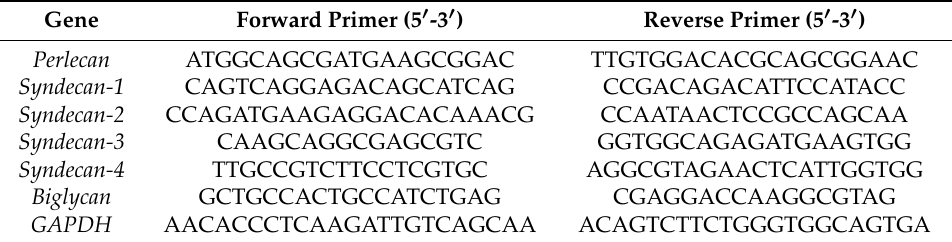
Table 1. Bovine gene-specific primers for